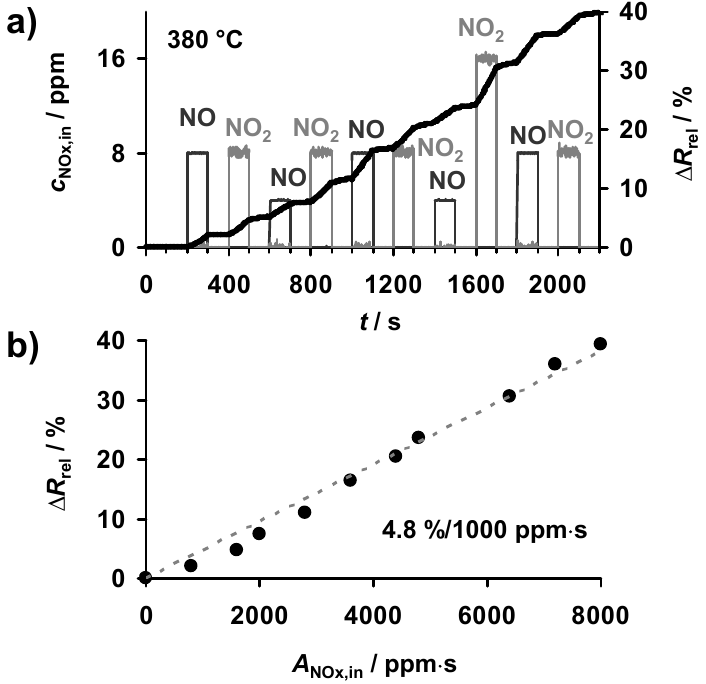
Figure 5. NO sensing properties at 380 °C (10% O x ( a ) stepwise increase of sensor response ∆ R or NO , ( b ) resulting linear ∆ R 2